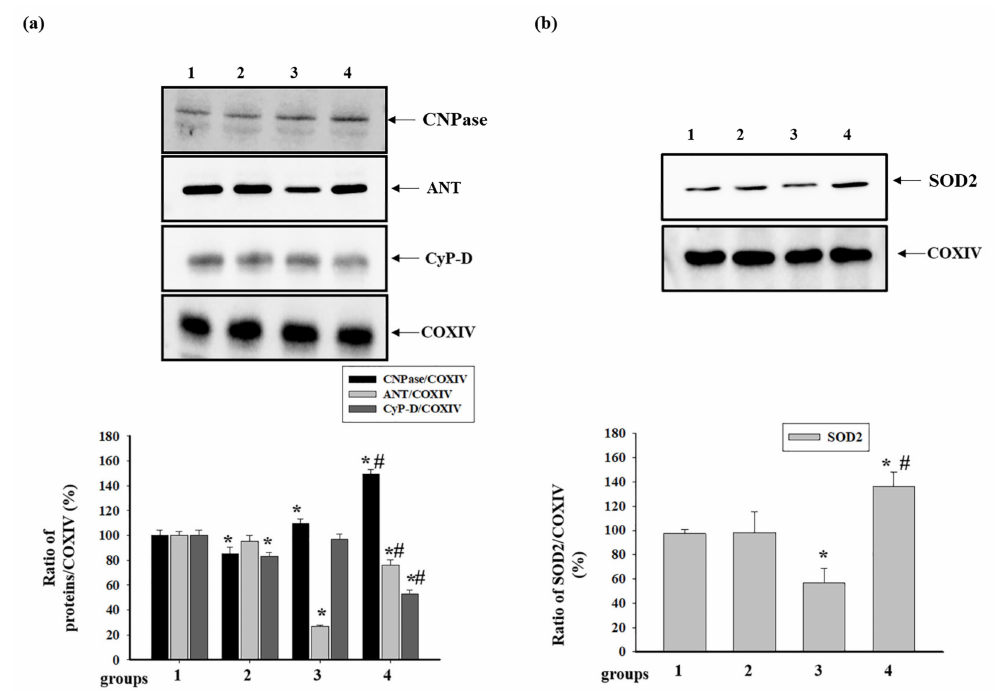
Figure 4. E ff ect of the administration of AST and ISO on the content of mitochondrial proteins: cyclophilin D (CyP-D), adenine nucleotide translocator (ANT),2 (cid:48) ,3 (cid:48) -cyclic nucleotide-3 (cid:48) - phosphodiasterase (CNPase), and superoxide dismutase 2 (SOD-2). ( a ) The upper part: Western blots stained with the corresponding antibodies (CNPase, ANT, and CyP-D); the lower part: a diagram quantitatively reflecting changes in protein content in absolute units normalized to COX IV. ( b ) The upper part: Western blots stained with the antibody to SOD-2; the lower part: a diagram quantitatively reflecting changes in the content of SOD-2 in absolute units normalized to COX IV. The data are presented as the means ± SDs of four independent experiments. * p < 0.05 significant di ff erence in protein level compared with the control (group 1), # p < 0.05 compared to RHM from ISO-injected rats (group 3). The statistical significance of the di ff erences between the pairs of mean values was evaluated using the Student-Newman-Keul test (Supplementary Materials, p.